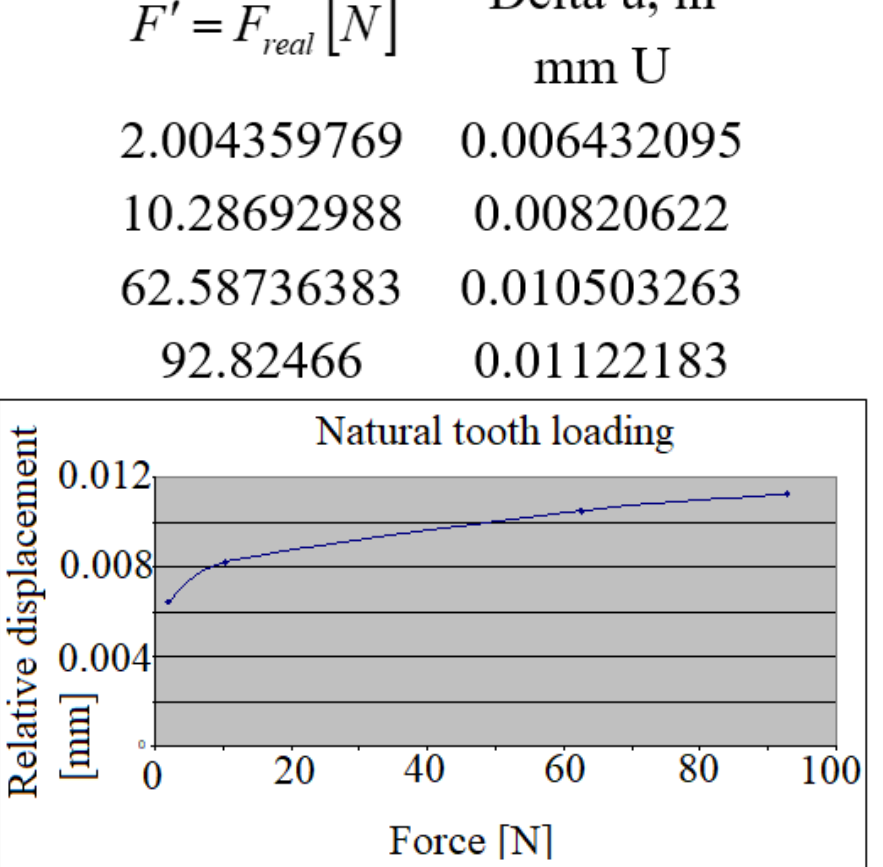
Figure 10. The relative displacement of the crowns during the natural tooth’s loading.